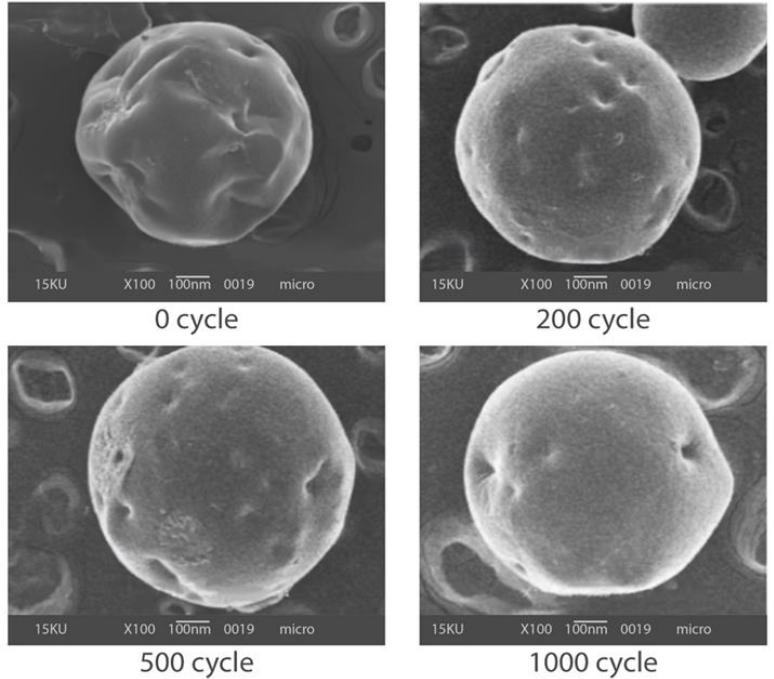
Figure 5. SEM images of paraffin particles after micro-encapsulation and subjected to thermal cycles [74].